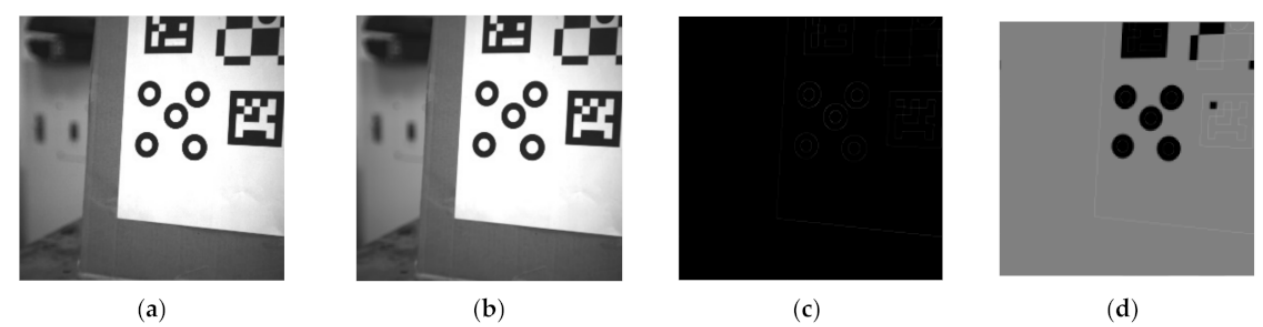
Figure 3. ( a ) The input image; ( b ) Gaussian blurred image; ( c ) Canny edge detection image; ( d ) Floodfill image. The flooding algorithm [13] is used to fill the connected domains of the image. The (0,0) coordinate point on the image is set as the initial point and then spread from the initial point to the nearby pixels; then, it is assigned the pixel value to 127 to produce Figure 3d. Finally, the area with a pixel value of 127 is deleted and excluded them from subsequent